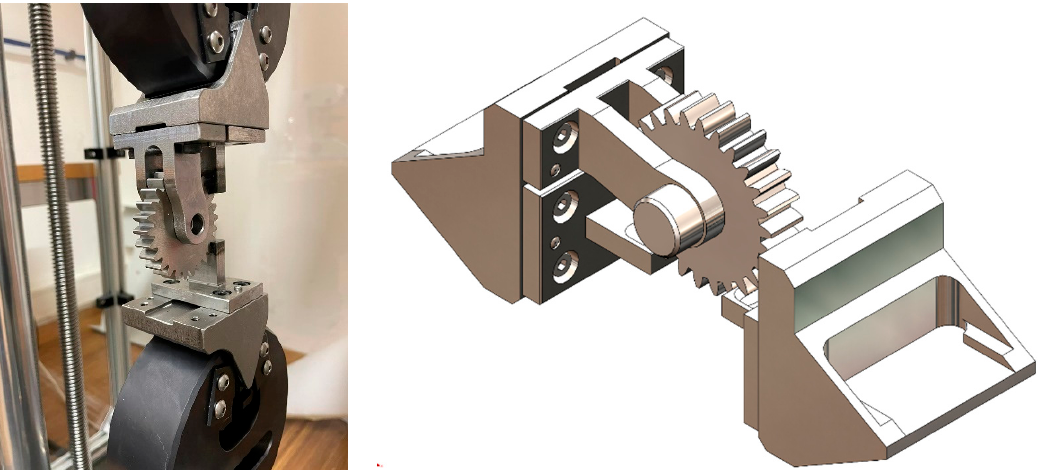
Figure 2. Scheme of the testing apparatus.